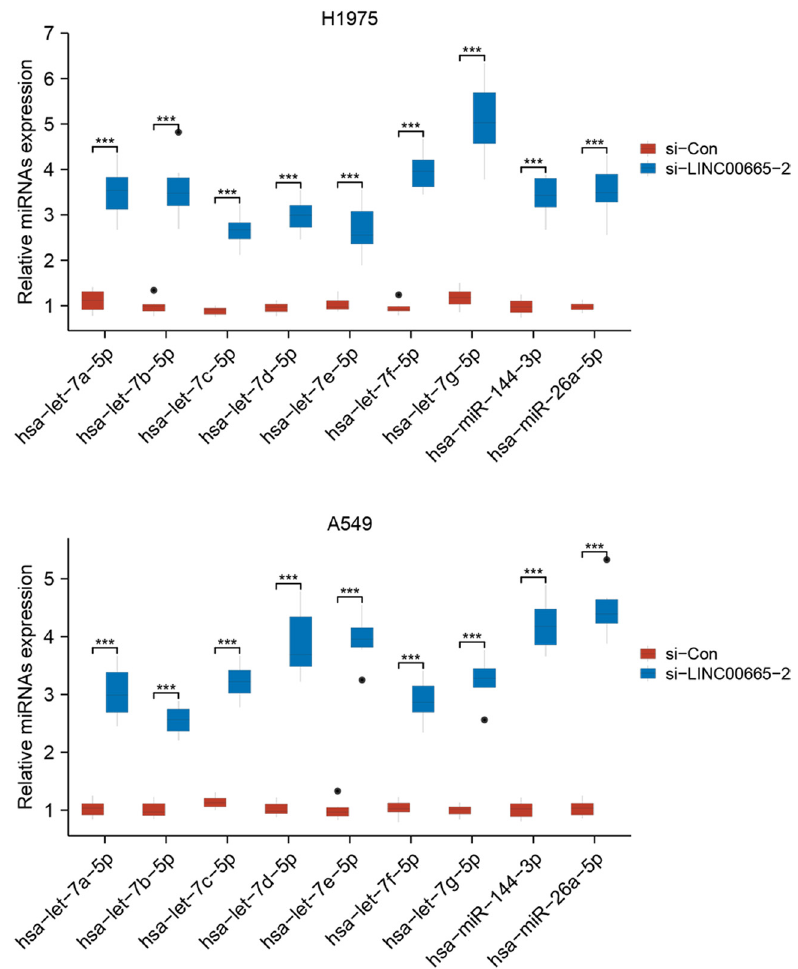
Figure A1: LINC00665 regulates miRNAs expression in LUAD cells. After transfection with si - Con or si - LINC00665 into H1957 and A549 cells, 9 miRNAs ( hsa - let - 7a - 5p, hsa - let - 7b - 5p, hsa - let - 7c - 5p, hsa - let - 7d - 5p, hsa - let - 7e - 5p, hsa - let - 7f - 5p, hsa - let - 7g - 5p, hsa - miR - 144 - 3p, hsa - miR - 26a - 5p ) expression were measured using RT - PCR. ∗∗∗ P < 0.001 compared with control